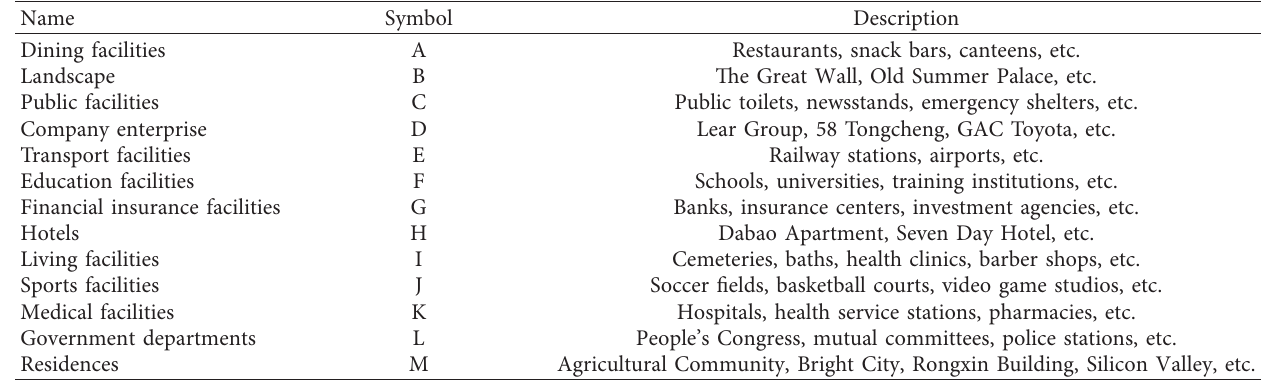
Table 3: The description of POI data.